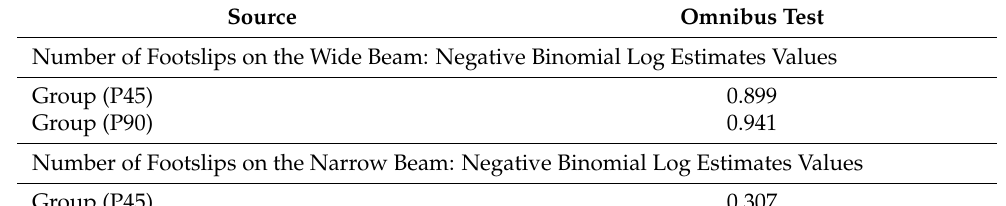
Table A10. Negative binomial model with log estimates values table for the number of footslips in the beam walking test. Source Omnibus Test